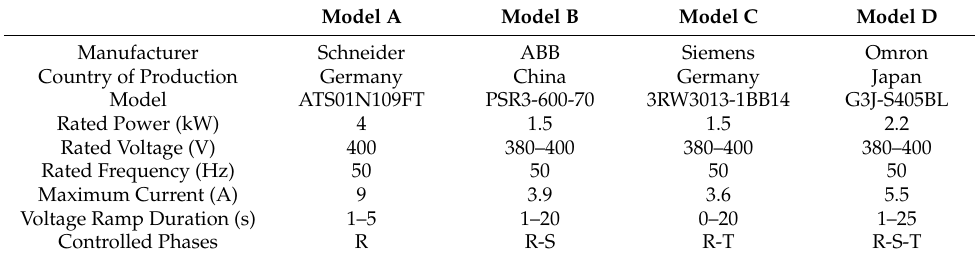
Figure 11. Models of tested soft starters: ( a ) Schneider ALTISTART 01; ( b ) ABB PSR3-600-70; ( c ) Siemens SIRIUS 3RW3013-1BB14; ( d ) Omron G3J-S405BL. Table 7. Main characteristics of the four models of soft starter